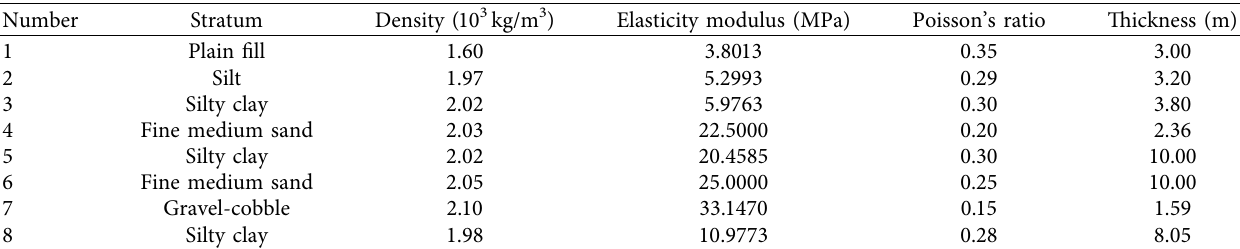
Figure 4: Formation model of the area around Pile No. 28 Table 1: Local layer parameters.